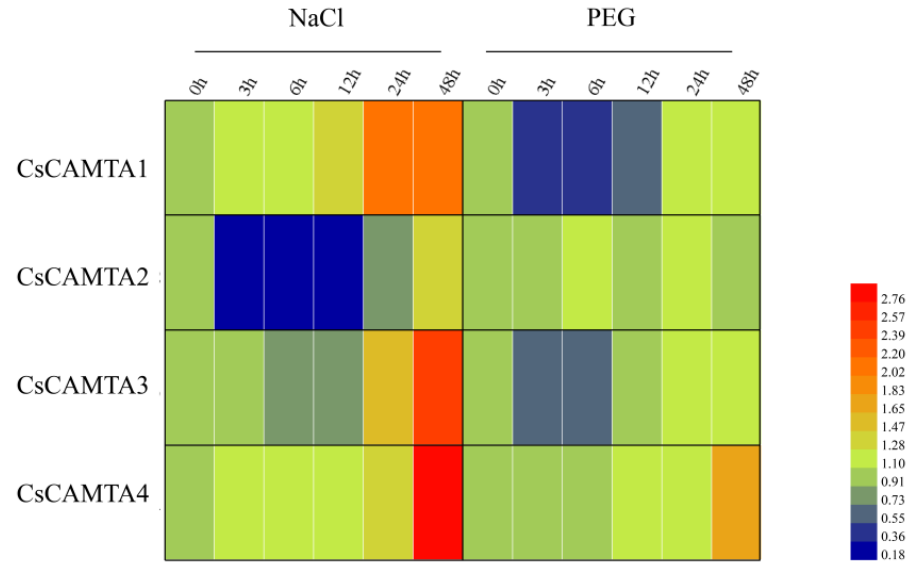
Figure 7. The expression pattern of CsCAMTA genes in leaves treated with NaCl and PEG. The sampling time points were 0, 3, 6, 12, 24, and 48 h. Red and blue indicate high and low levels of expression level, respectively. The color bar represents the expression values.